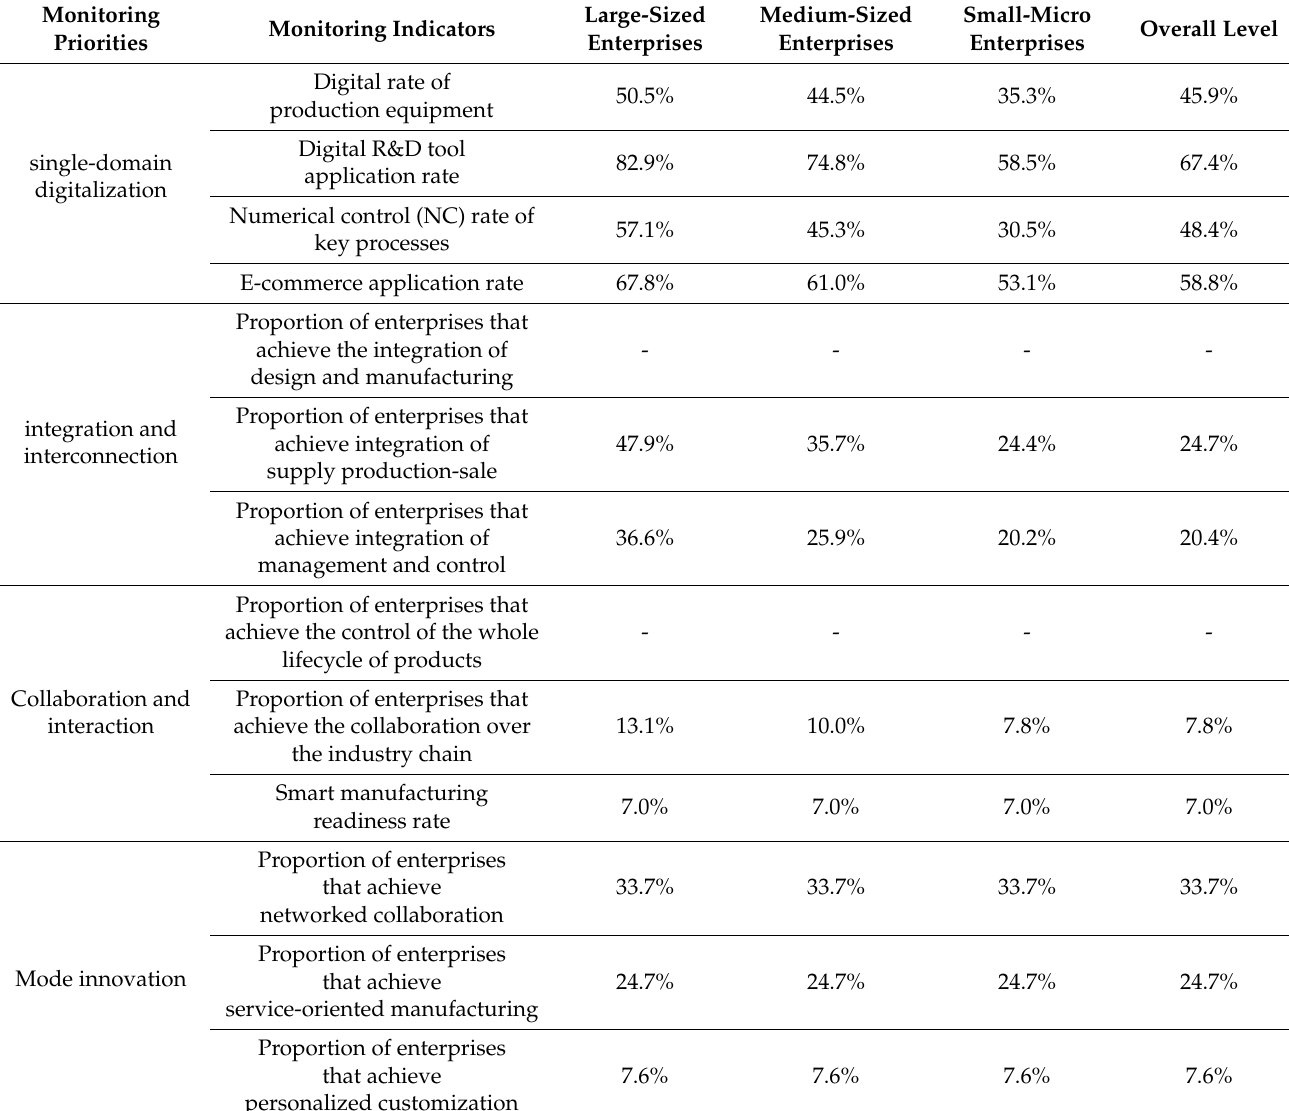
Figure 9. Annual growth of digital transformation of enterprises of different sizes. Table 6. Overview of Sectors’ Digital Transformation in China (2018).